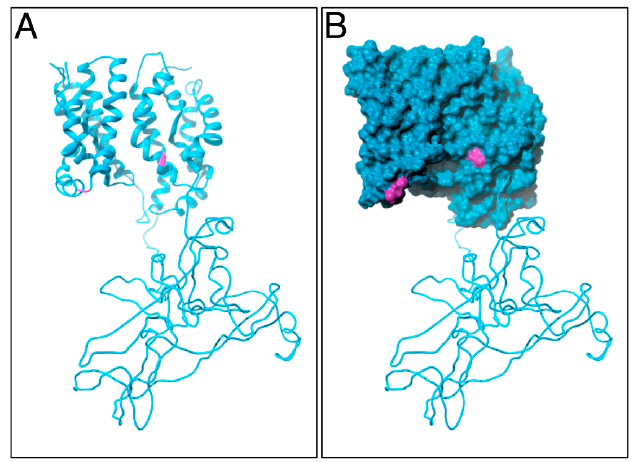
Figure 4. A 3-D model for PIN2: Ribbon diagram ( A ) and surface representation ( B ) of assembled 3-D structural predictions for PIN2. The position of both cysteines is labeled in pink. Rendering was performed within Chimera (https://www.cgl.ucsf.edu/chimera/) [31] using POV-Ray (http://www.povray.org/).